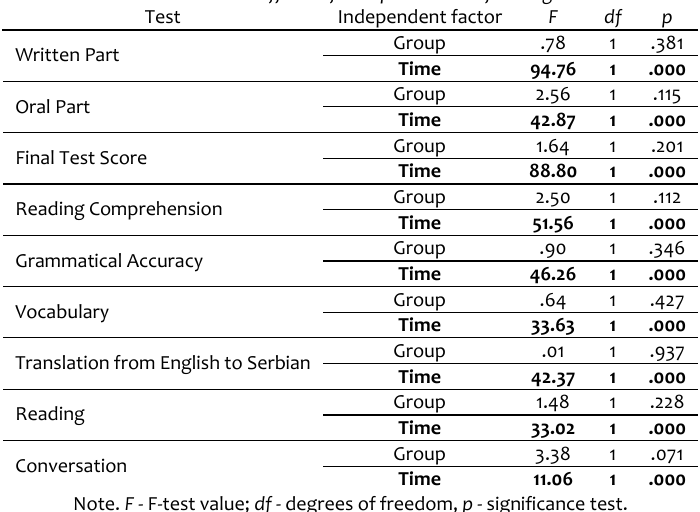
Table 2. Main effects of Group and Time of testing